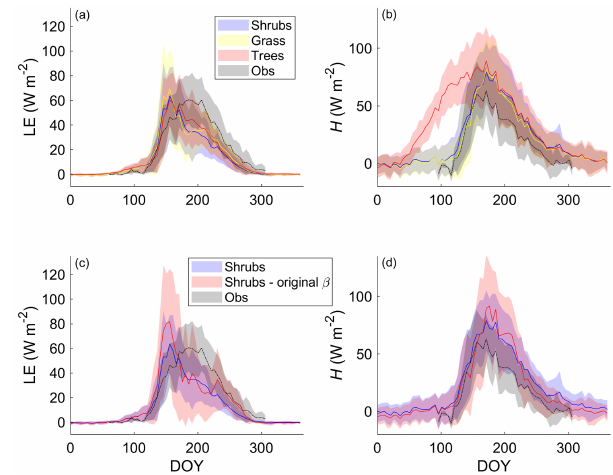
Figure 4. Mean 5d average (a) latent ( LE ) and (b) sensible heat flux ( H ) over 2004–2017 for the shrub, grass, and tree simulations using the new β formulation (Merlin et al., 2011) and (c) LE and (d) H using the new and the original β formulation (Lee and Pielke, 1992) along with EC tower observations. Shaded areas show the standard deviation of the daily mean for